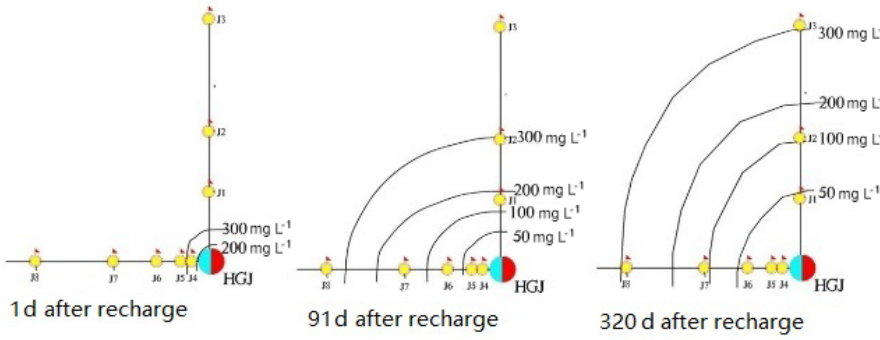
Figure 7. Radial distribution characteristics of Cl − ion